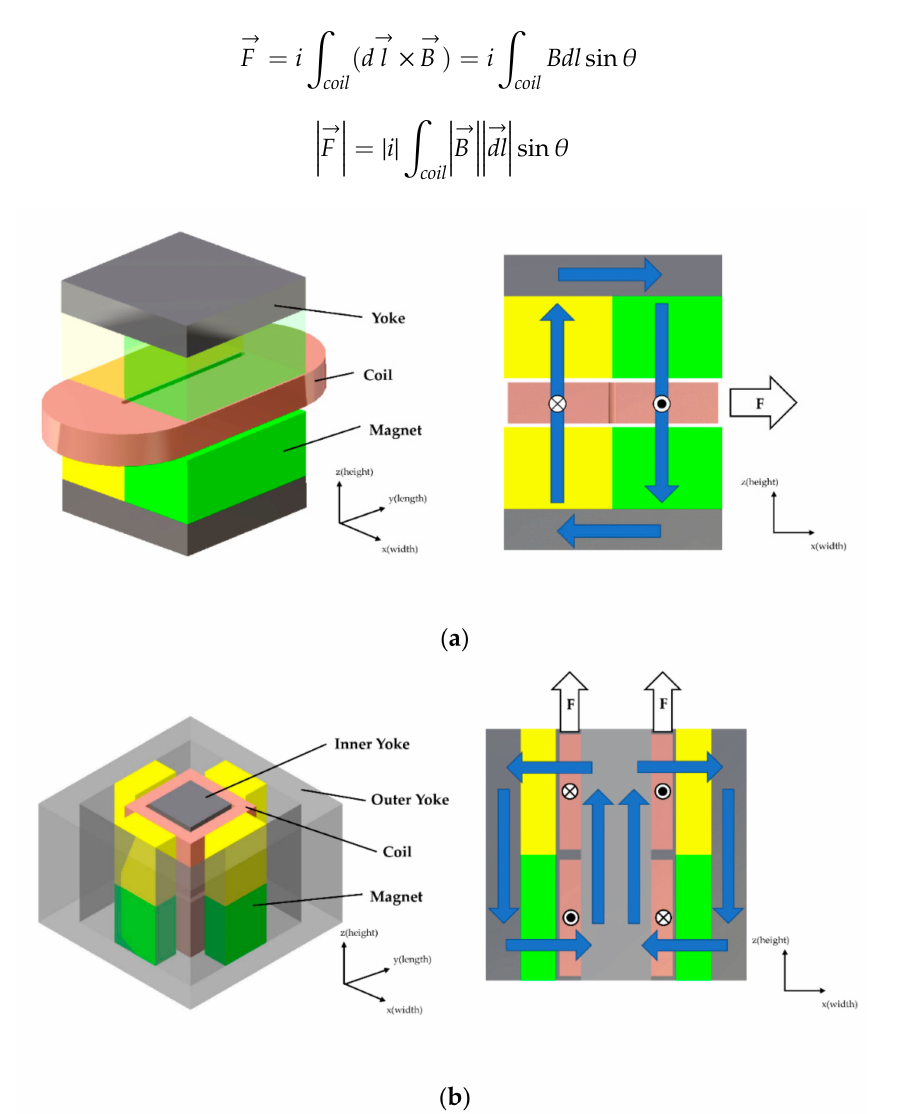
Figure 1. ( a ) Structure of a typical voice coil motor (VCM) with double-sided magnets, ( b ) Structure of a square column type